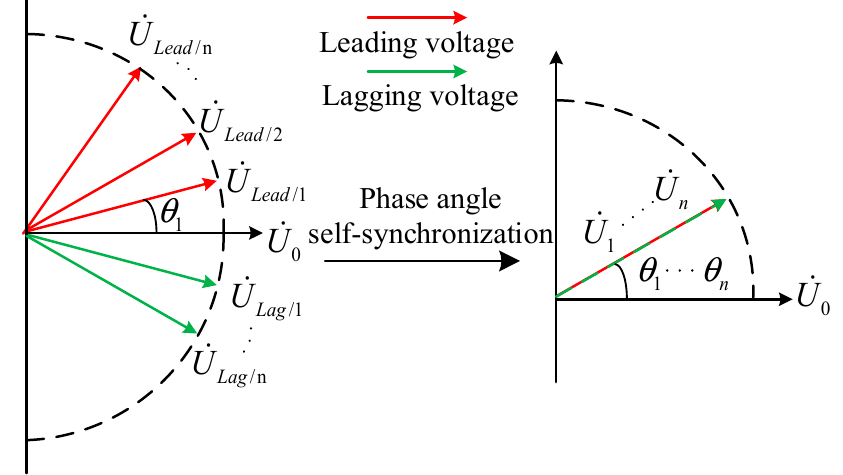
Figure 8. Phase angle conversion process using phase angle self-synchronization strategy.